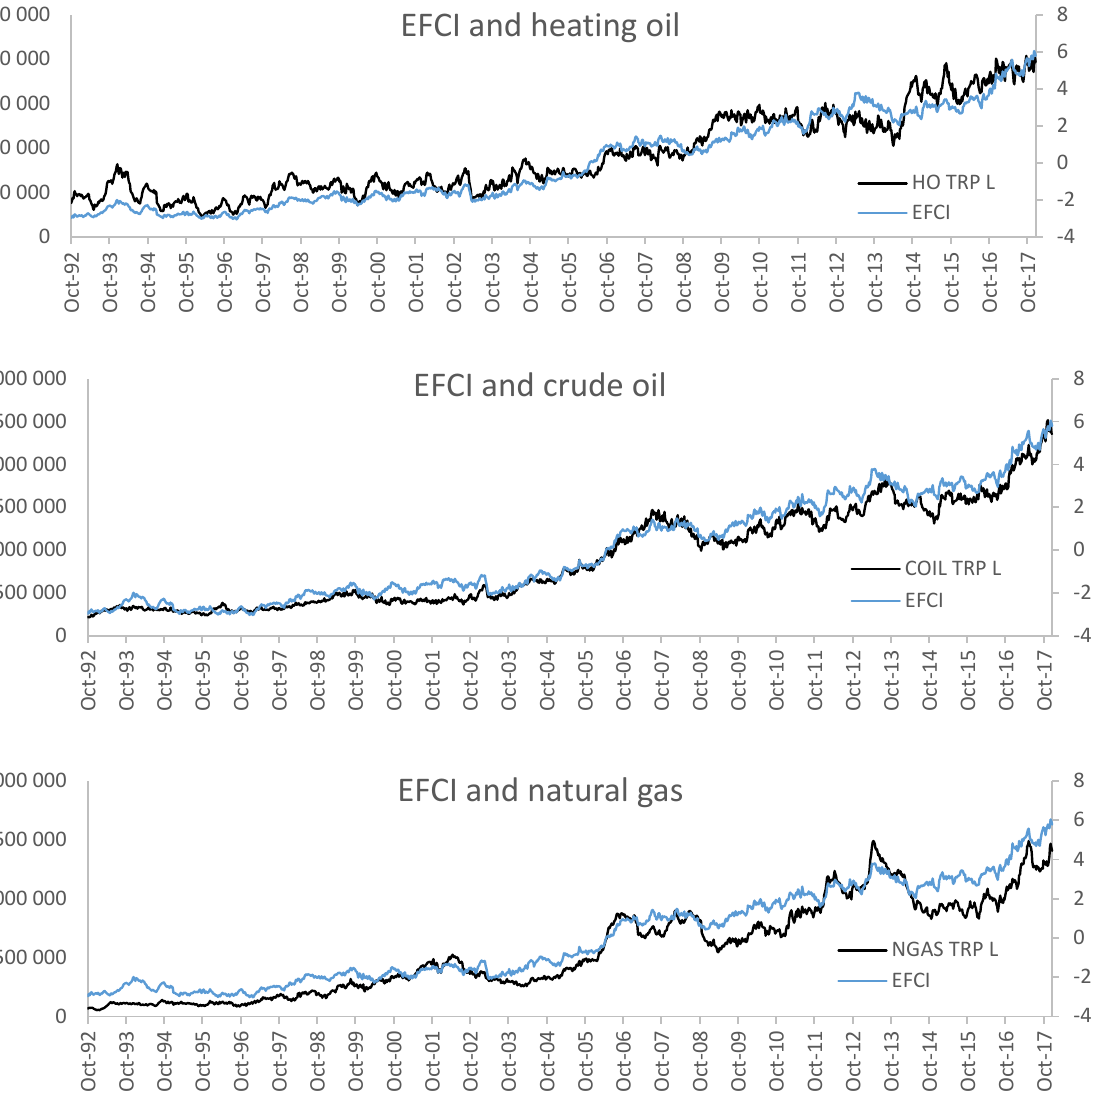
Figure 3. Energy Futures Conditions Index model